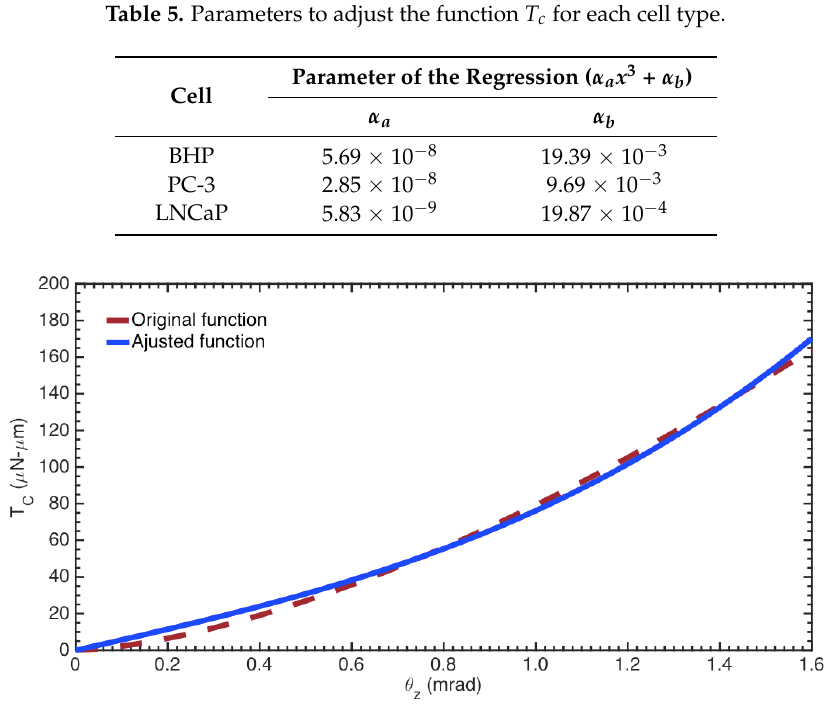
Figure 16. Adjusted function of the resistive torque T c for a BPH